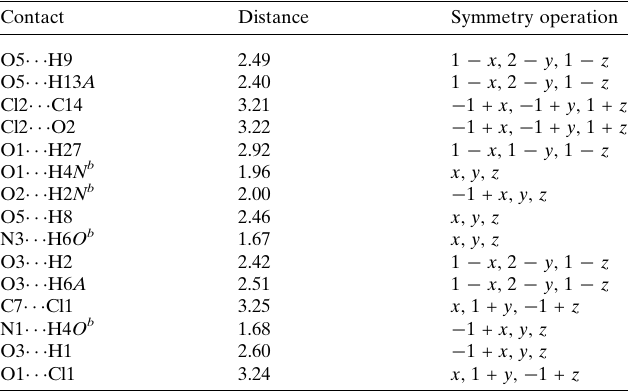
Table 2 A summary of short interatomic contacts (A˚ ) in (I) a